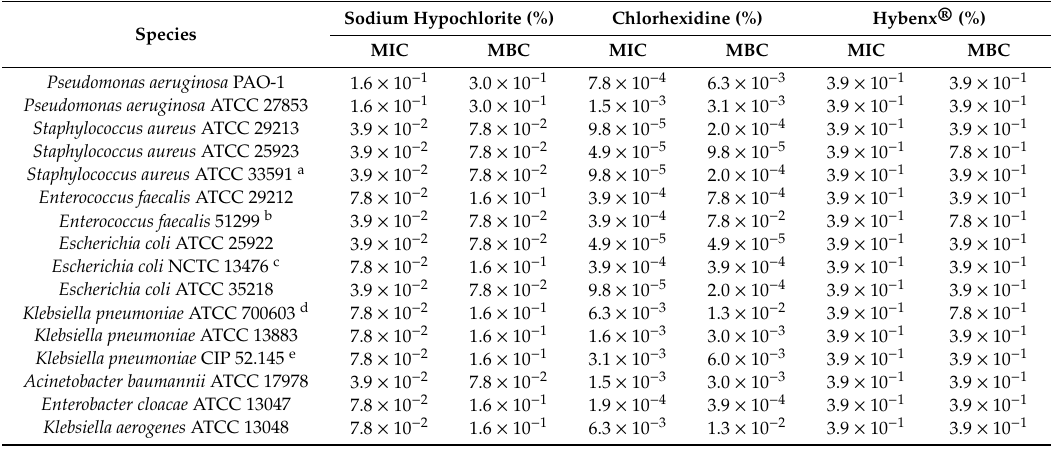
sodium hypochlorite and chlorhexidine on a collection of Gram-negative and Gram-positive strains.